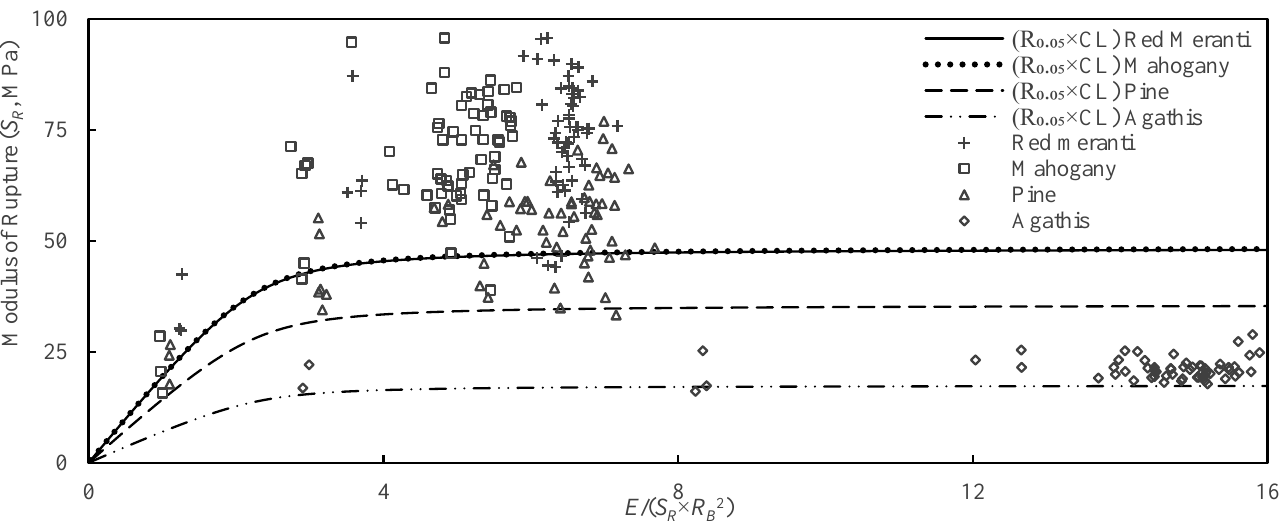
Figure 10. Experimental result of modulus of rupture ( S R ) compared to the characteristic strength multiplied by the beam stability factor ( R 0.05 × C L ) (Note: E and S R on abscissa are the average value of the small-size specimen).